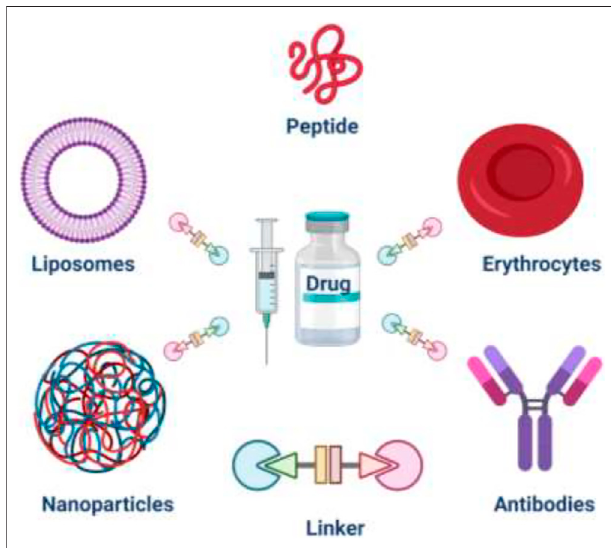
FIGURE 1 | Drug delivery system (DDS)